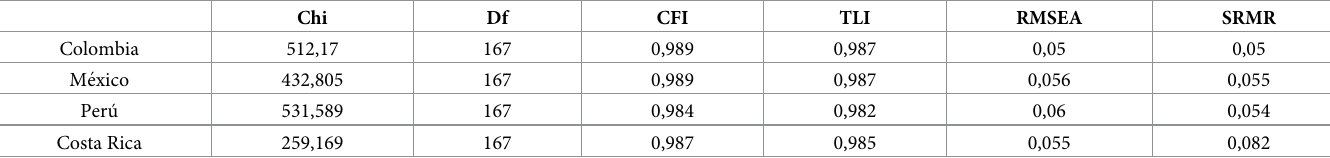
Table 4. Confirmatory factor